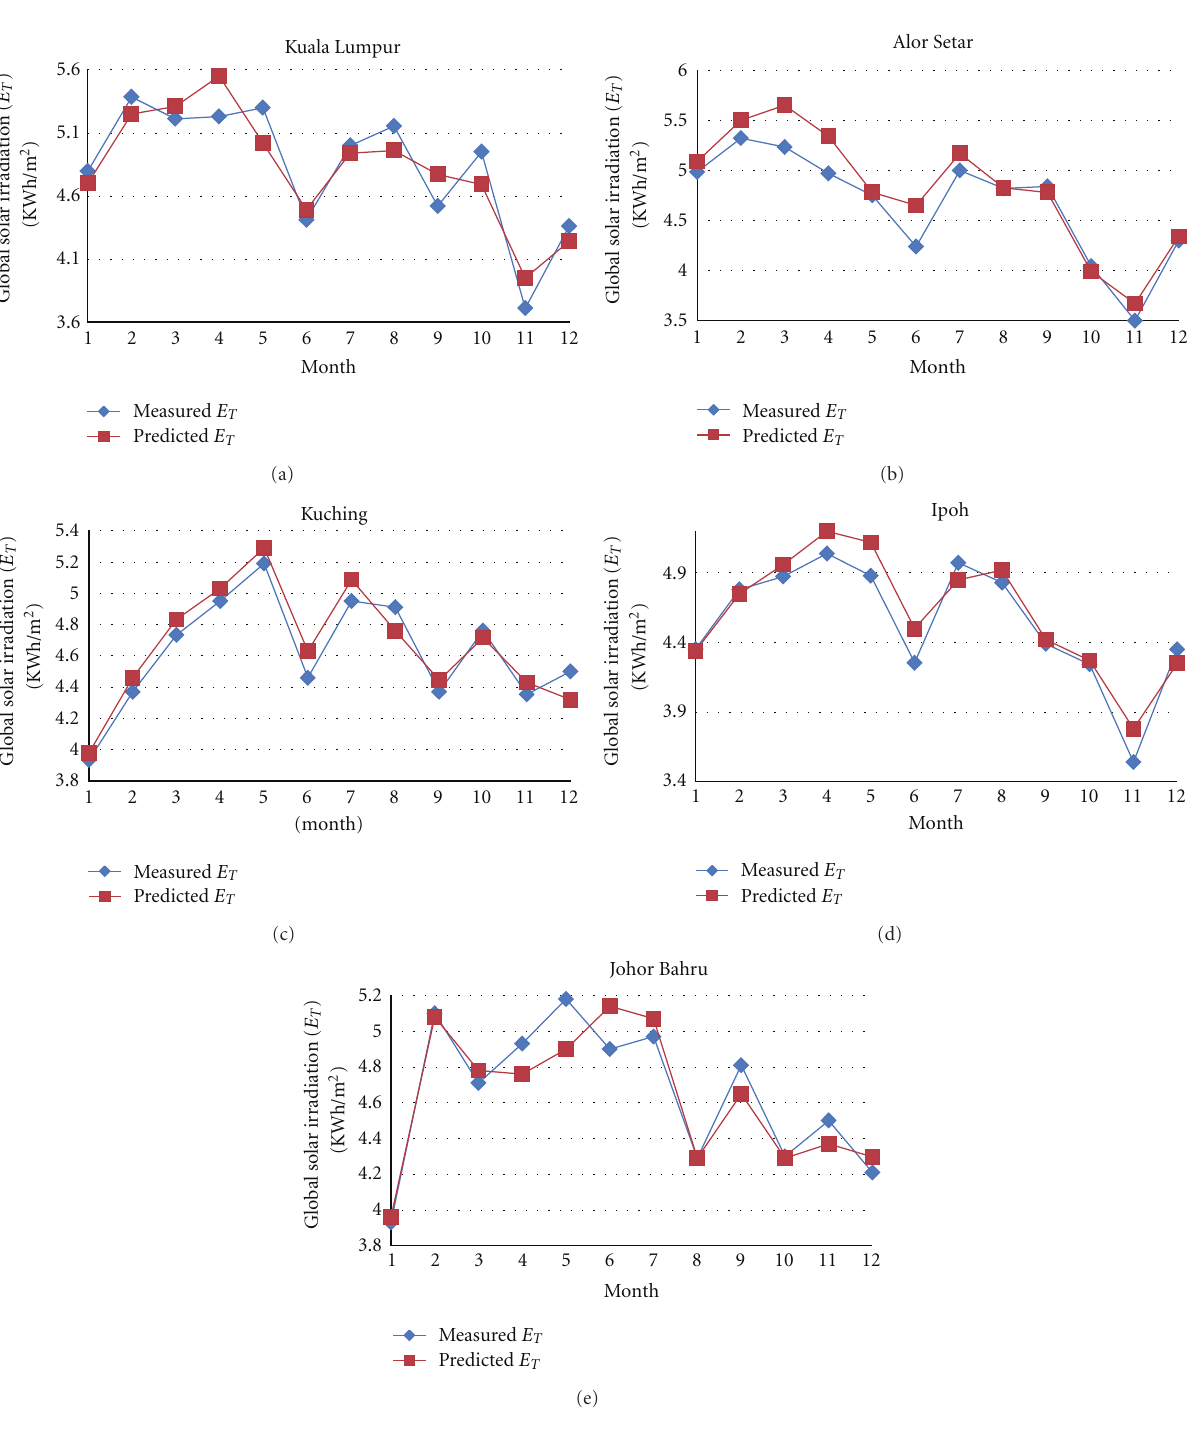
28 sites in Malaysia. The developed network predicted the clearness indexes. The clearness indexes were then used to predict the global solar irradiation. Additionally, estimations of the di ff used solar radiation were proposed using an